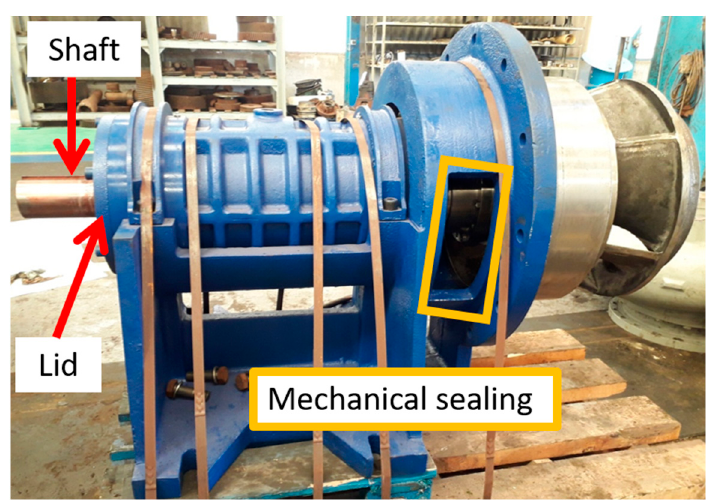
Figure 5. Picture of the rest of the parts produced locally.